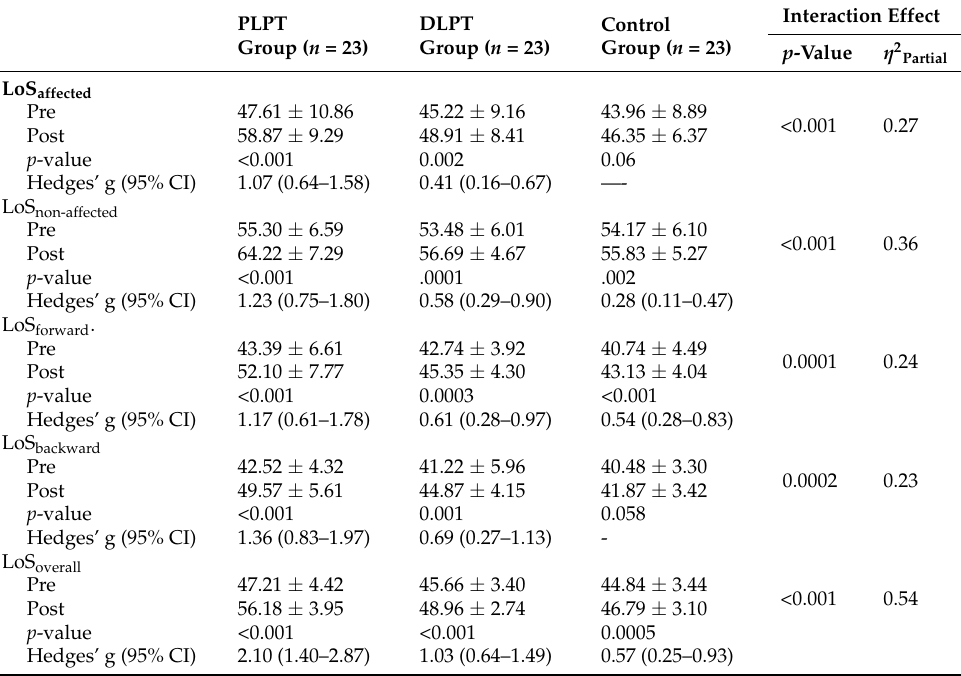
Table 3. Differences in balance capability outcomes among the study